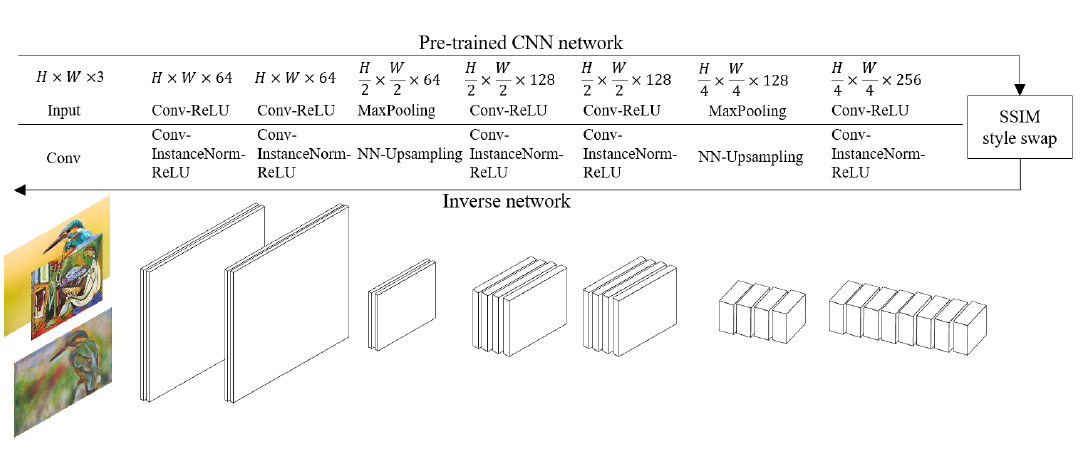
Figure 3. Pre-trained CNN and inverse network